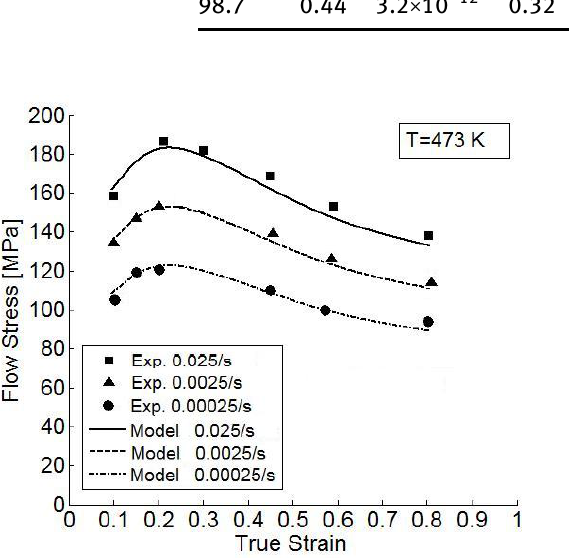
Figure 8: Predicted and experimental data at temperature of 493 K and different forming